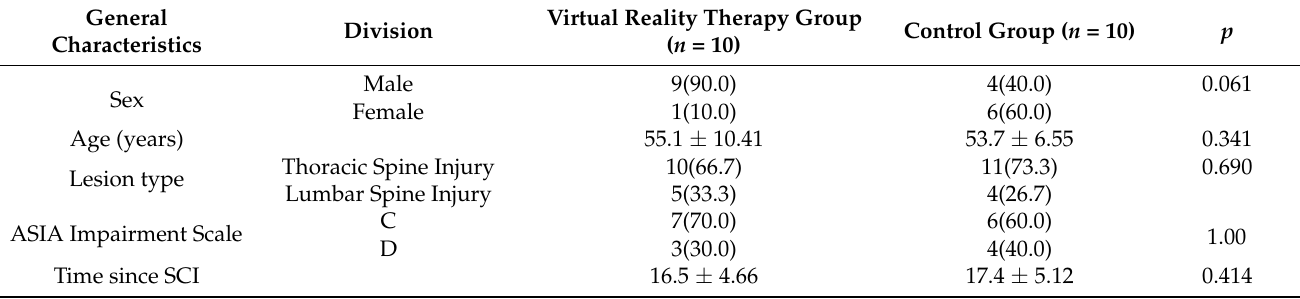
Table 1. Characteristics of